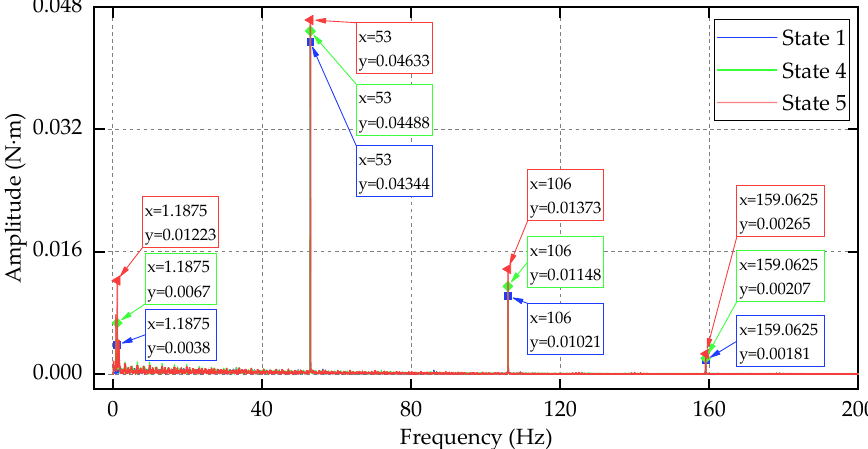
Figure 12. The frequency-domain curve of disturbance torque in tests 1, 4, and 5.